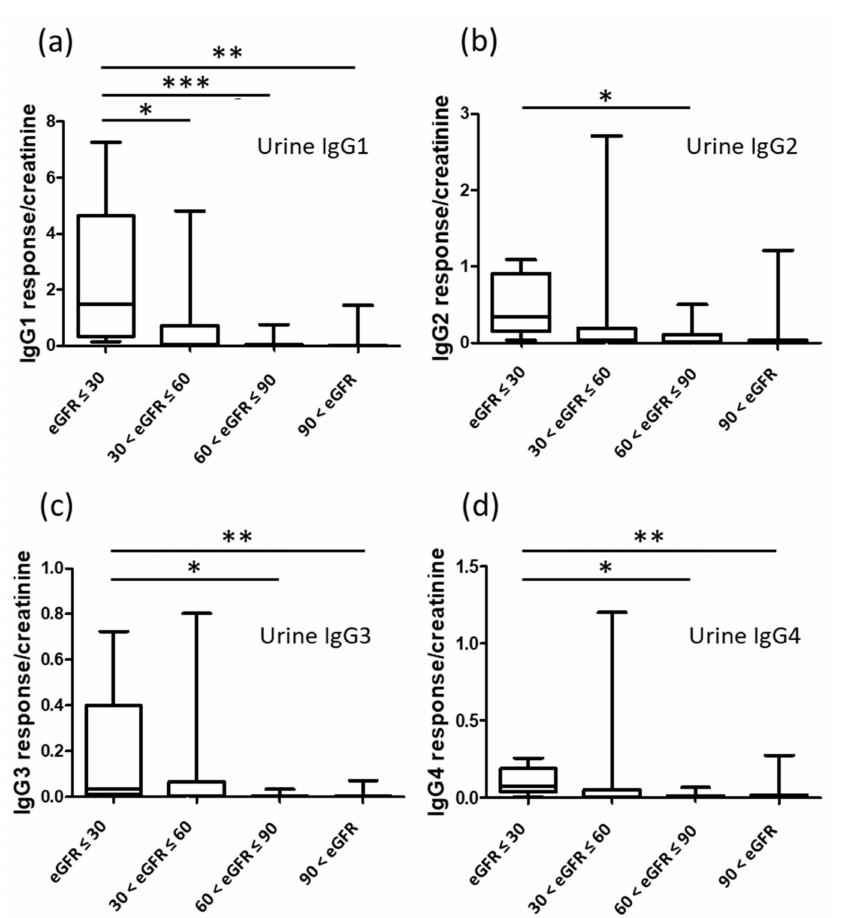
Figure 5. Comparison of the amount of urine IgG subclasses between the four groups with different eGFR values. ( a ) IgG1, ( b ) IgG2, ( c ) IgG3, ( d ) IgG4. p values represent statistically significant differences: * p < 0.05, ** p < 0.01, *** p <